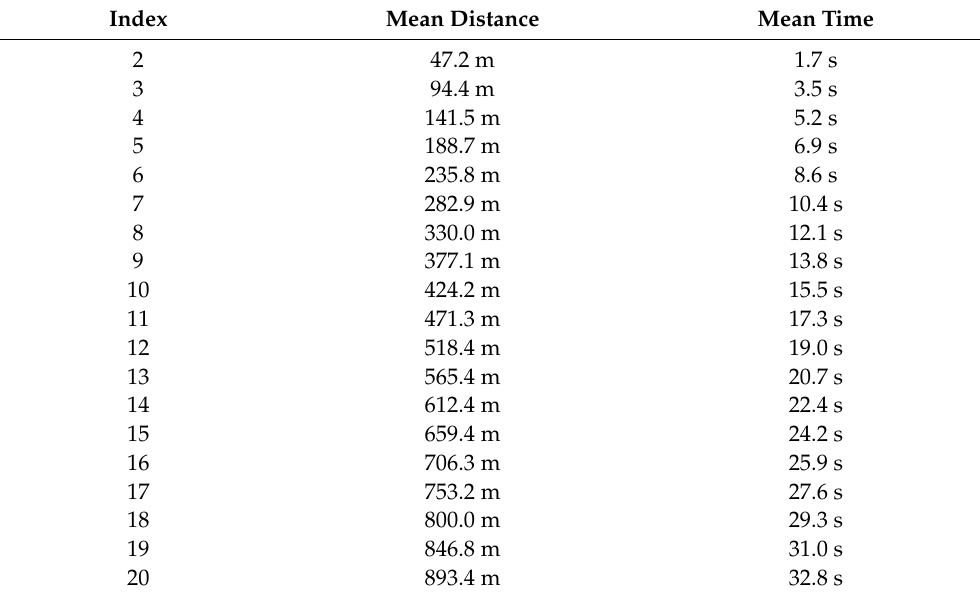
Table 4. The mean distance and mean time of the vehicles if all platoon members receive warn- ing early.